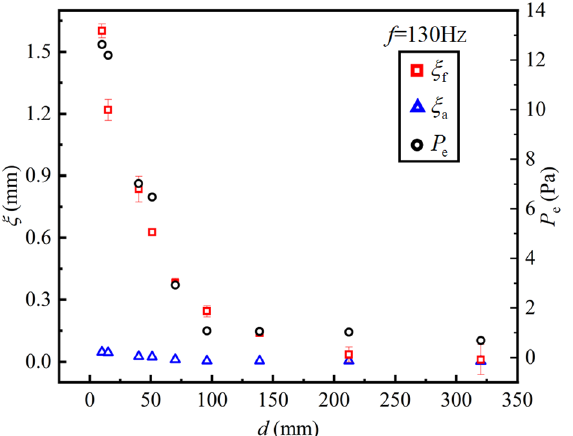
ξ and ξ under the same sound pressure, and the reduction trend with Figure 6. Comparison of Figure 6. Comparison of ξ f and ξ a under the same sound pressure, and the reduction trend with f a increasing distance d . increasing distance d